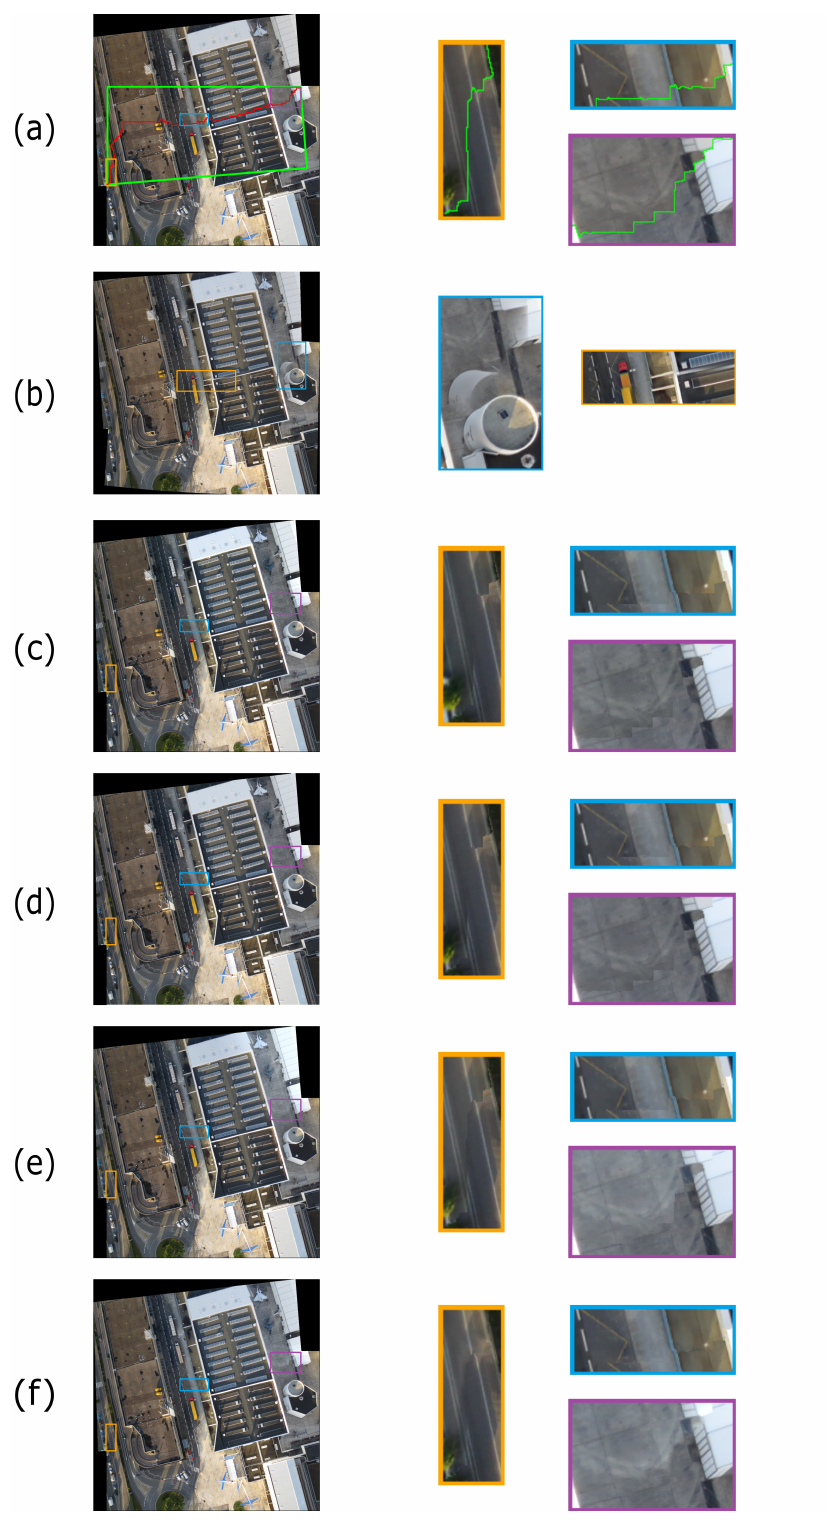
Figure 9. The perceptual quality merit of our method for the second testing stitched image taken from S 1 under − 15% brightness update. ( a ) The testing stitched image and the amplified sub-images near the stitching line. ( b ) The MBB method [18]. ( c ) The HM-based method [19]. ( d ) The GP-based method [21]. ( e ) The GBJI-based method [23]. ( f ) Our